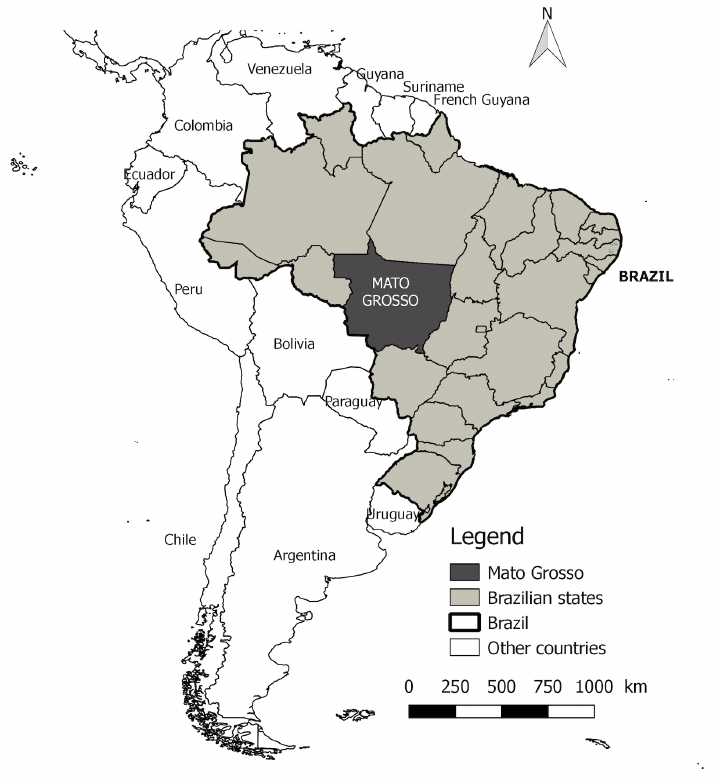
Figure 1. The location of Mato Grosso in